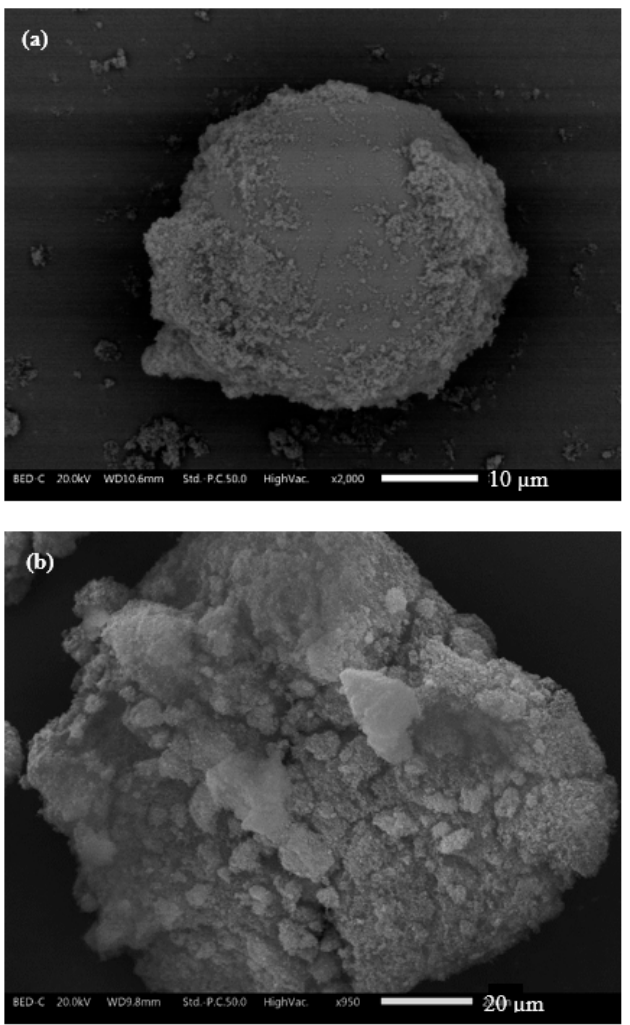
Figure 4. ( a , b ) SEM images of the morphologies of different PP waste particles. Table 4. Point EDXS analysis on PP waste particles.